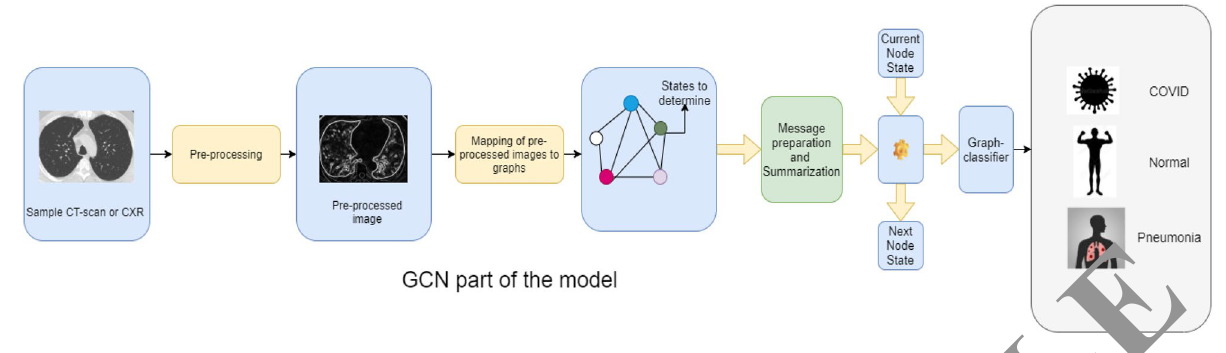
Figure 2. Generic framework of our proposed GraphCovidNet model for COVID-19 detection from CT-scan or CXR images (Sample CT-scan image source: CT-scan—SARS-COV-2 Ct-Scan Dataset 8 ).